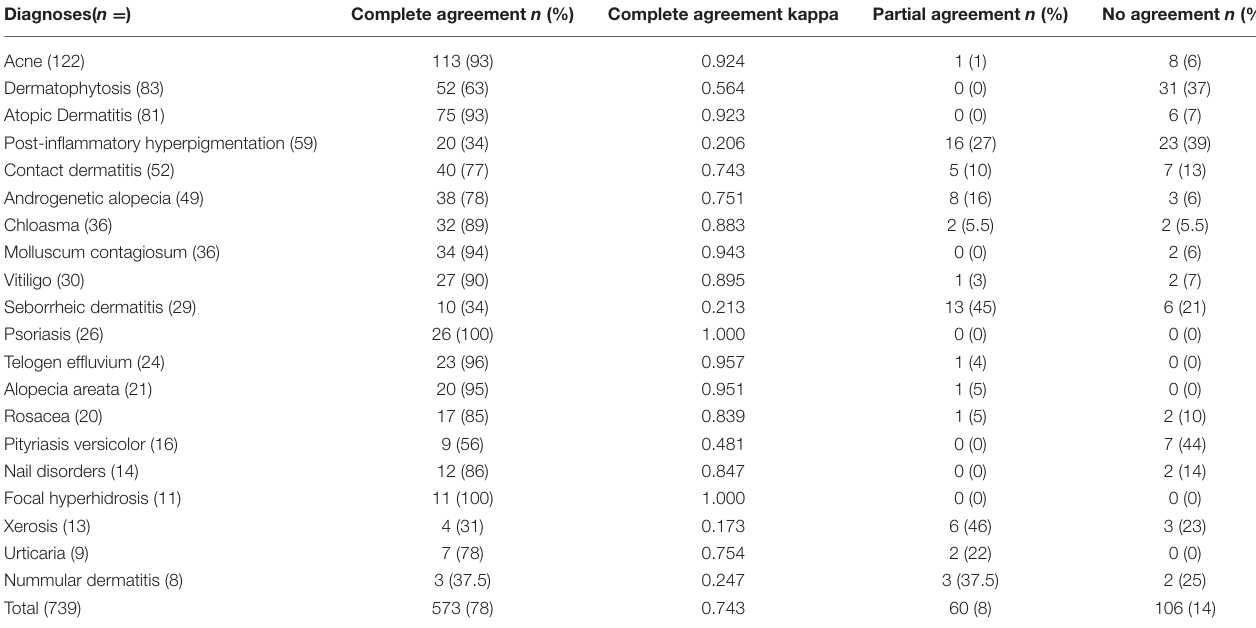
TABLE 3 | Most frequent inflammatory dermatosis diagnosed by in-person dermatologists and agreement with teledermatology diagnoses. Diagnoses( n = )